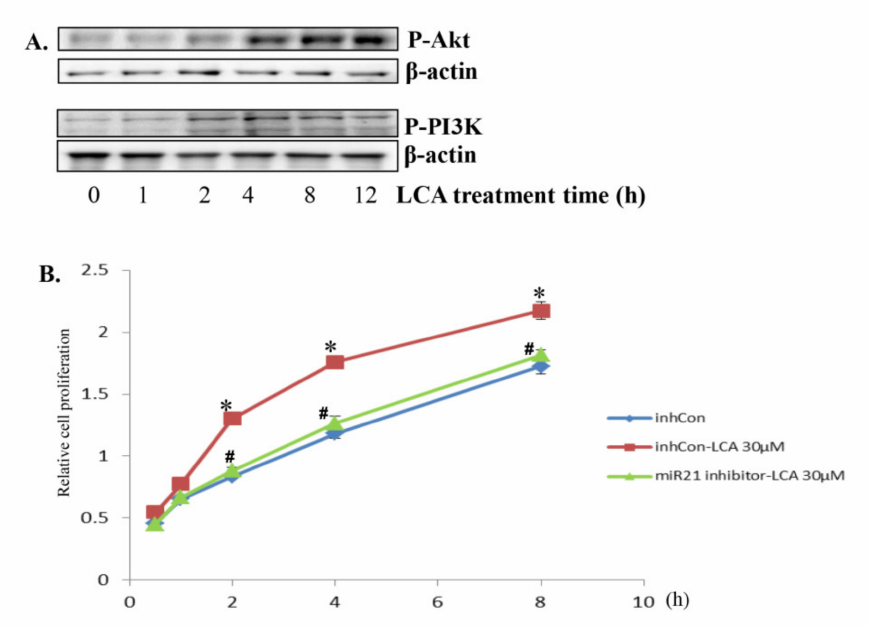
Figure 8. LCA activates Akt/PI3k signaling and enhances HCT116 cell proliferation. ( A ) 30 µ M LCA was treated with HCT116 cells for 1 h–12 h and extracted for total protein for checking Phosphorylated Akt and PI3K by Western blot. ( B ) HCT116 cells transfected with 50 nM miR21 inhibitor or inhibitor negative control (inhCon) were treated with 30 µ M LCA for 24 h. The cells were then checked for proliferation by EZ-Cytox assay. * p < 0.05 versus control; # p < 0.05 versus only LCA. The above data represent the means ± SD from triplicate